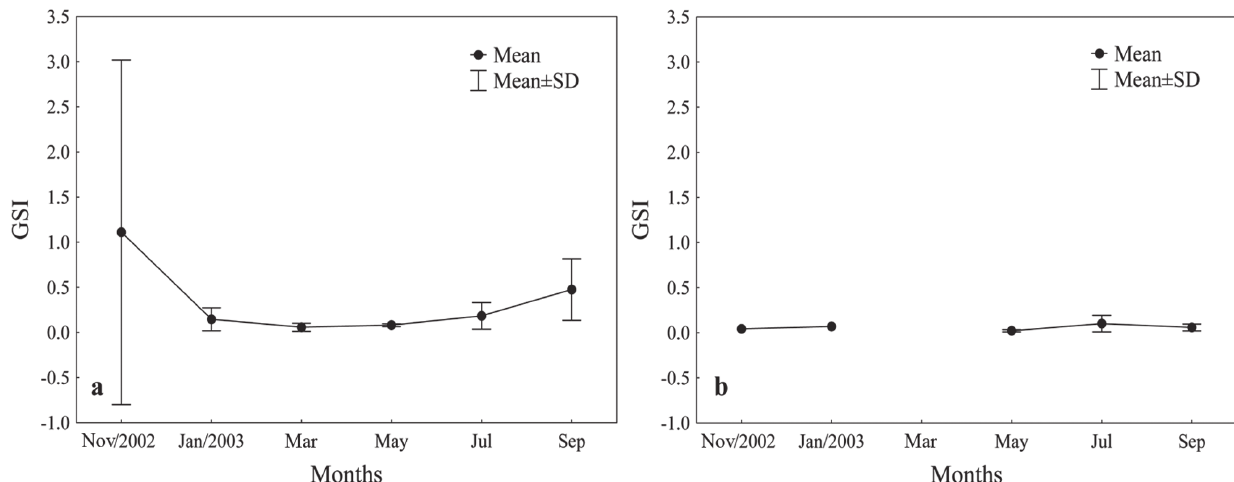
Fig. 8. Bimonthly variation of the mean values of the gonadosomatic index (GSI) of females (a) and males (b) of Iheringichthys labrosus in the Piquiri River from November 2002 to September 2003. (SD = Standard